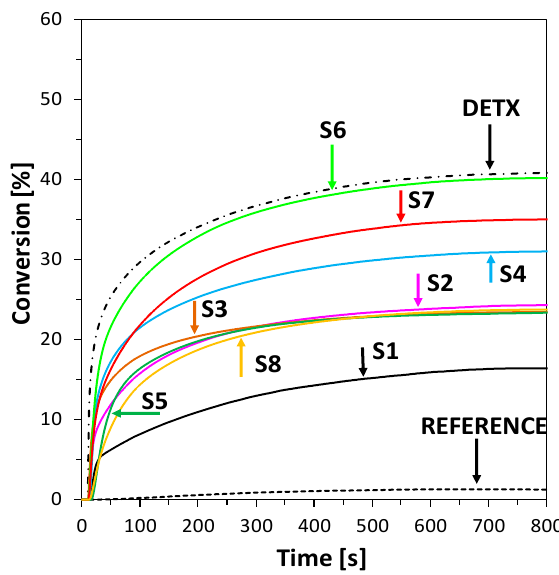
Time [s] Figure 12. Profiles of CADE epoxy groups conversion with HIP (1 wt.%) and 2-amino-4,6-diphenyl-pyridine-3-carbonitrile derivatives (0.1 wt.%) under MPM lamp with 400–500 nm filter (intensity at the surface of sample 75 mW/cm 2 ) irradiation, calculated from photo-DSC data. The irradiation starts at t = 10 s.